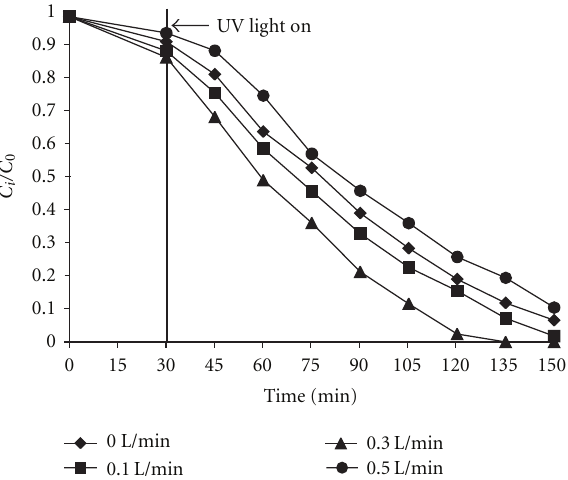
Figure 9: Influence of air flow rate on the photocatalytic degrada- tion of aqueous phenol solution. Experimental conditions: catalyst comprised TiO 2 nanotubes, silica gel, and colloidal silica in the ratio of 3:2 :20, medium pH = 3, and initial phenol concentration =